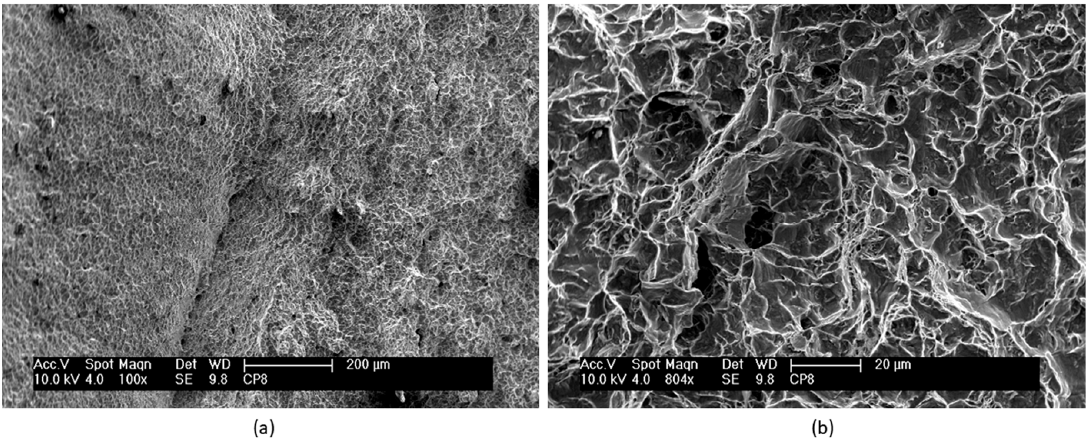
Figure 11. Scanning electron micrographs of the final rupture region on the fracture surface of the plasma nitrided specimen that was fatigue tested at 610 MPa and 90,800 cycles to failure. ( a ) Dimples. ( b ) Detail of the dimples.